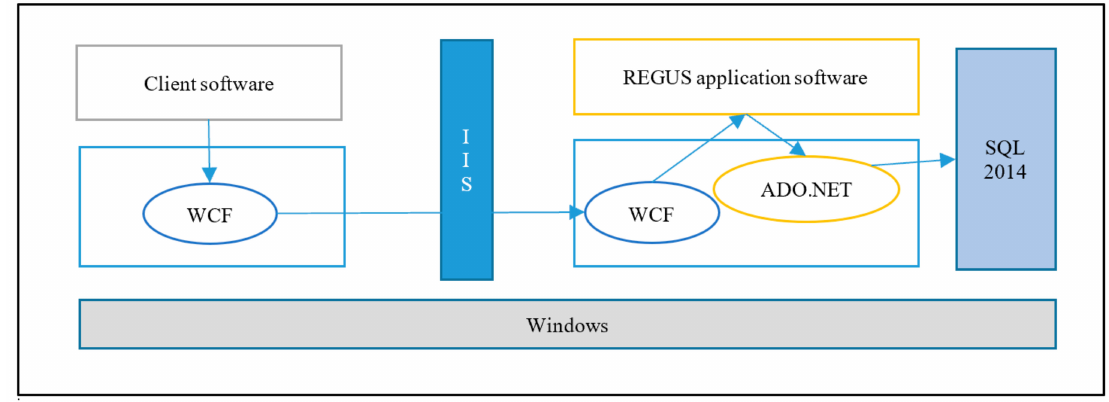
Figure 12. REGUS use of WCF platform for service communication and ADO.NET for database